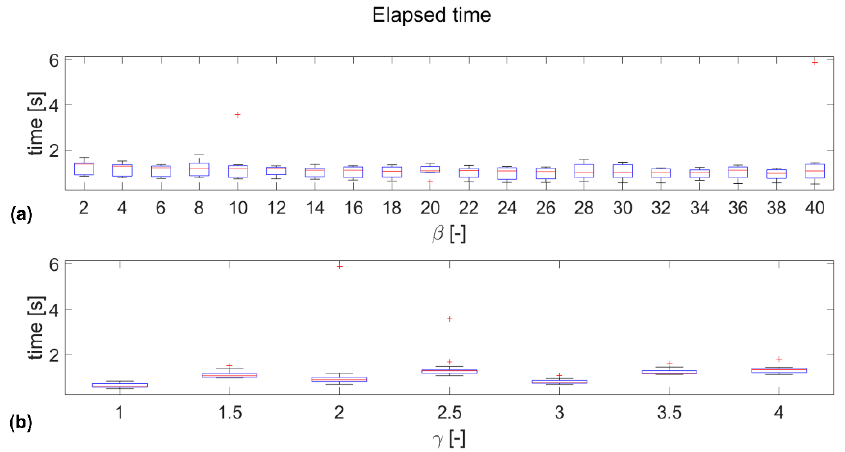
Figure 12. Boxplot of the CWT execution time. ( a ): as a function of β . ( b ): as a function of γ .